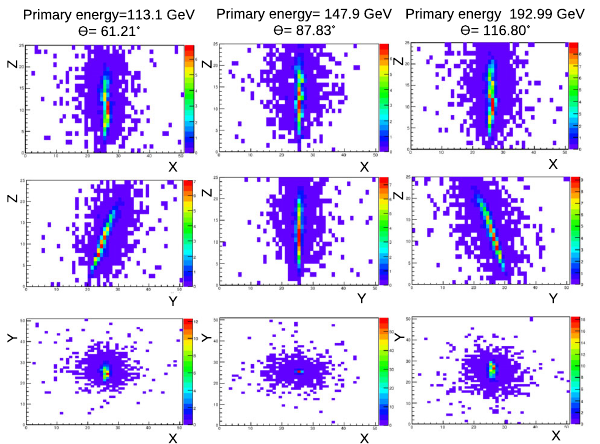
Fig. 7 GEN sample: electrons with different primary particle energies and angles